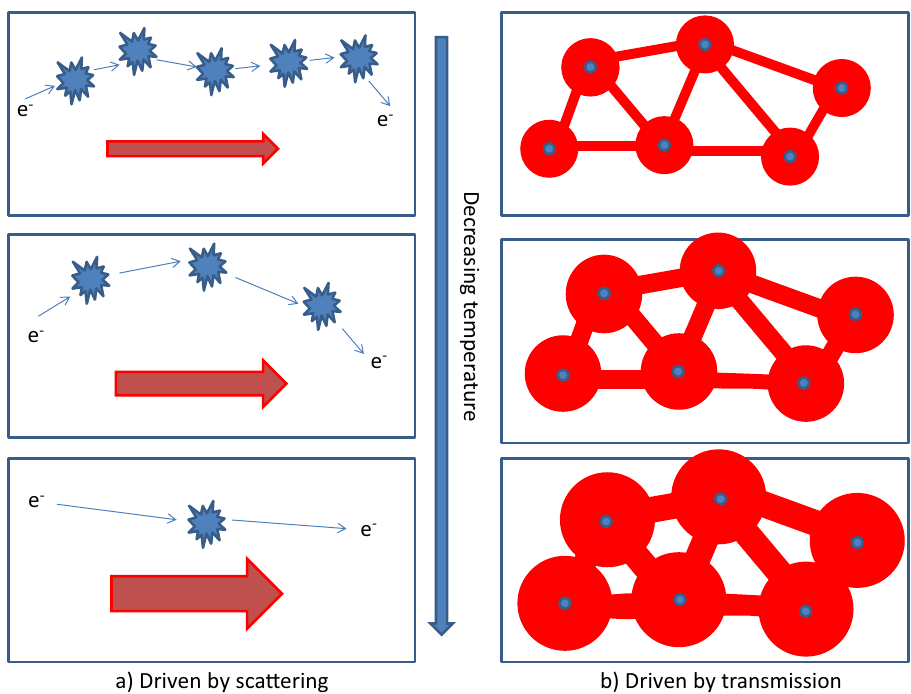
Fig. 4 Two pictures of temperature-dependent conductivity. a In a Drud – -Boltzmann picture of transport, cooling the system leads to a rare fi cation of scattering events. Conductivity increases because the time interval (and the spatial distance) between two successive scattering events increases with cooling. Such a picture requires a well-de fi ned quasi-particle across the distance in time and in space separating two scattering events. b In a Landauer picture of transport, each dopant (each oxygen vacancy here) is a reservoir connected to other adjacent reservoirs by conducting channels. Conductivity increases upon cooling because the transmission coef fi cient enhances. Such a picture does not require well-de fi ned